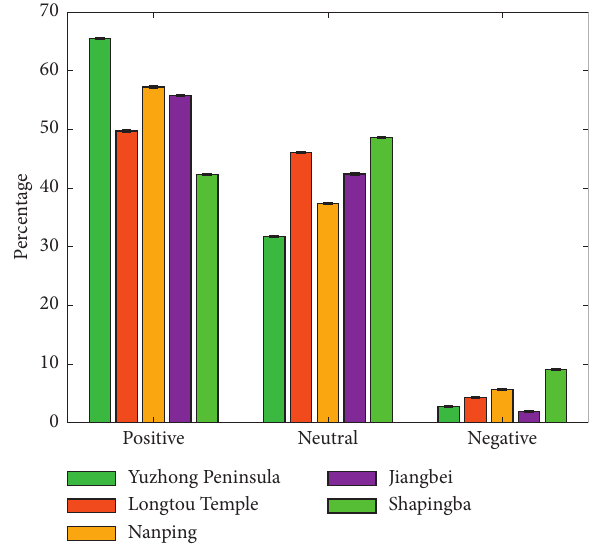
Figure 5: The statistics of city image